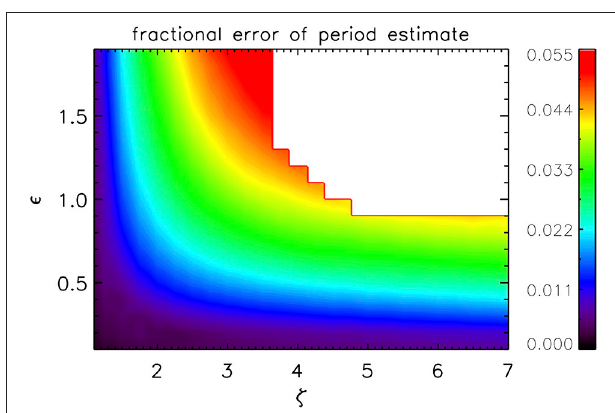
FIGURE 6 | Error in the period of oscillation estimate based on the TB approximation as given by Equation